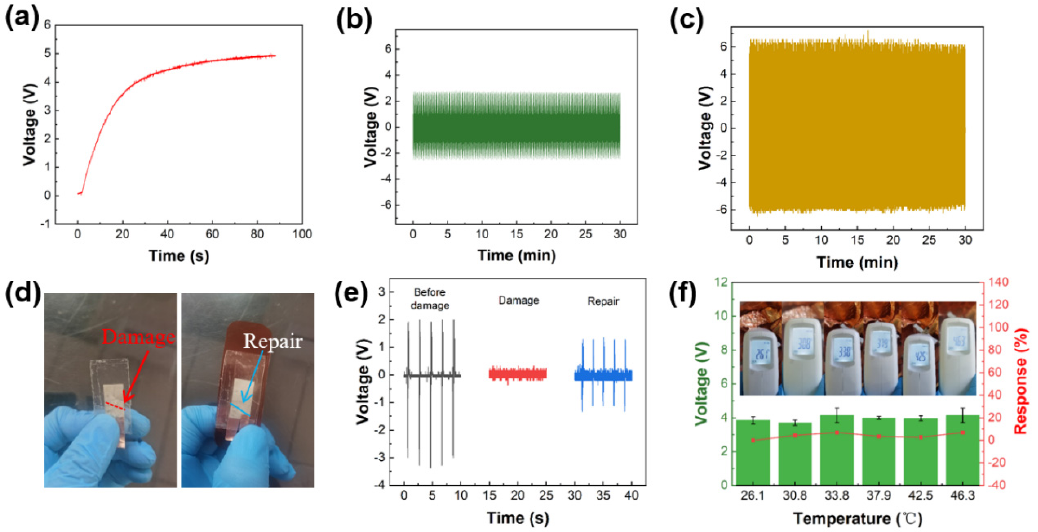
Figure 4. Performance test of the sensor. ( a ) Capacitor charging. ( b , c ) Durability test at different conditions. ( d ) Complete and damaged images of the sensor. ( e ) Comparison of output piezoelectric voltage of the damaged sensor. ( f ) Tempera- ture